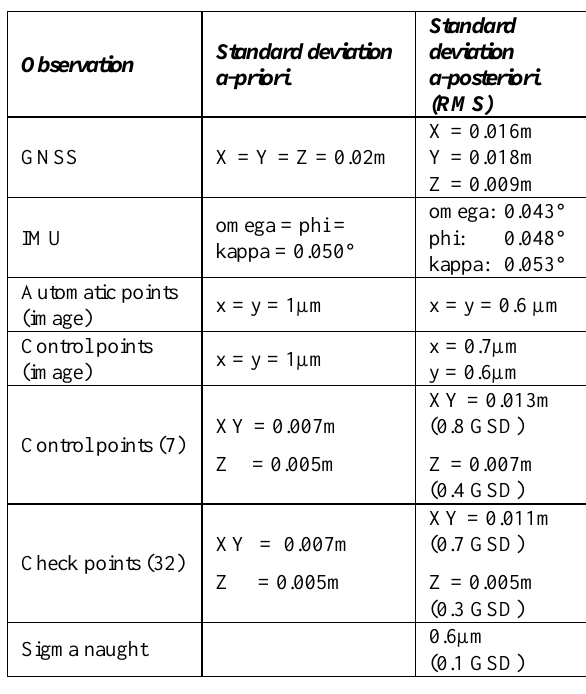
Table 3: Results of AT with 7 control and 32 check points